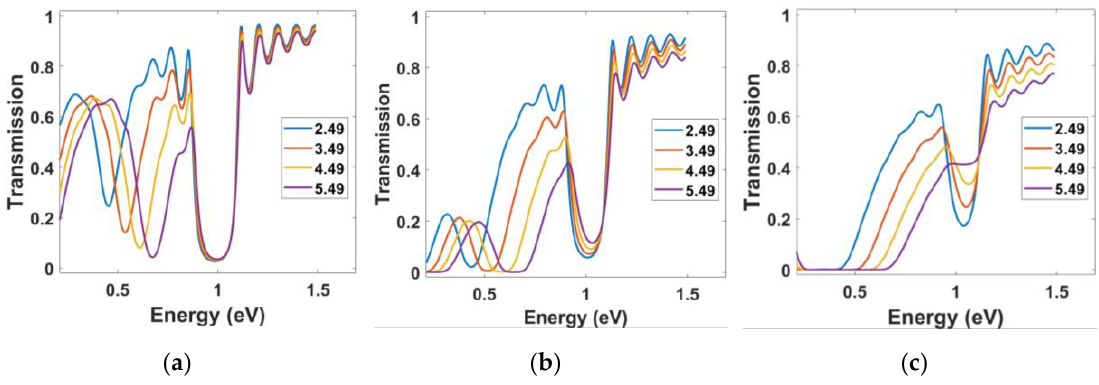
Figure 5. Light transmission spectra of the photonic crystal as a function of the doping level ( 2.49 × 10 26 charges m 3 ⁄ , 3.49 × 10 26 charges m 3 ⁄ , 4.49 × 10 26 charges m 3 ⁄ , 5.49 × 10 26 charges m 3 ⁄ ) for the ITO:TiO 2 ratio ( a ) 10:60, ( b ) 30:40, and ( c ) 60:10.